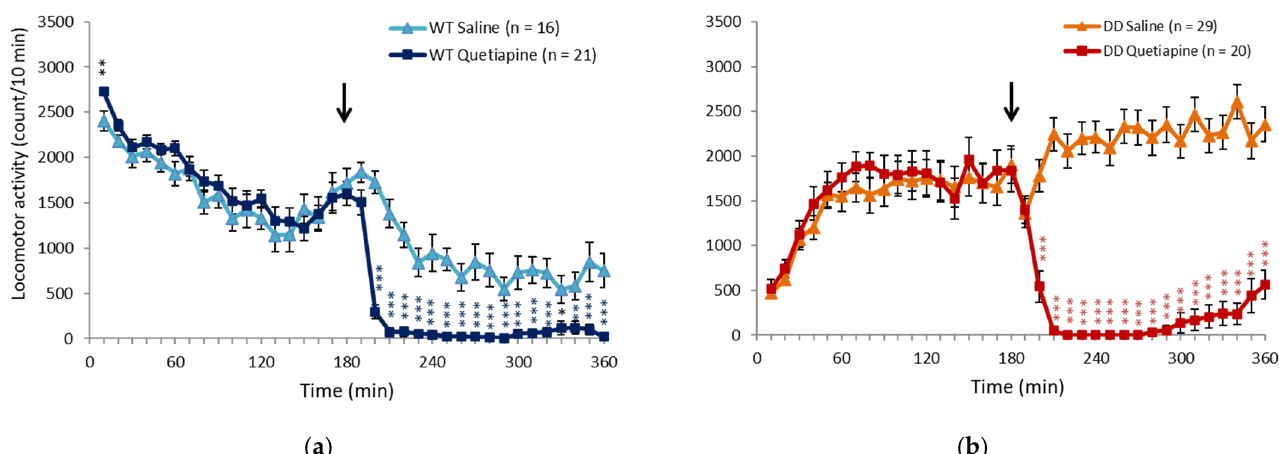
Figure 2. Changes in locomotor activity induced by 20 mg/kg quetiapine. ( a , b ) Changes in locomotor activity in ( a ) WT and ( b ) DD mice following quetiapine and saline administration. The arrows indicate the drug injection time. ** p < 0.01, *** p < 0.001, compared with saline (Student’s t -test). The graphs show the number of animals per group. The data are expressed as mean ± SEM. WT, wildtype mice; DD, dopamine-deficient mice.